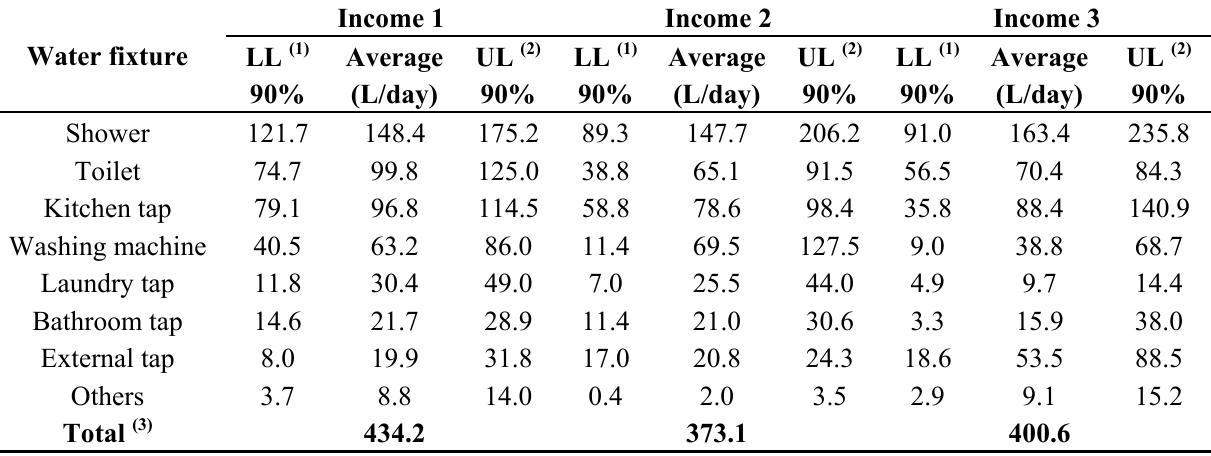
Table 5. Average, lower and upper limit values for the daily water consumption (per household) in water fixtures and